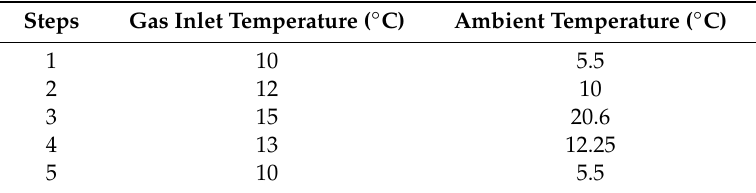
Table 2. Natural gas and ambient temperature in the five time steps.